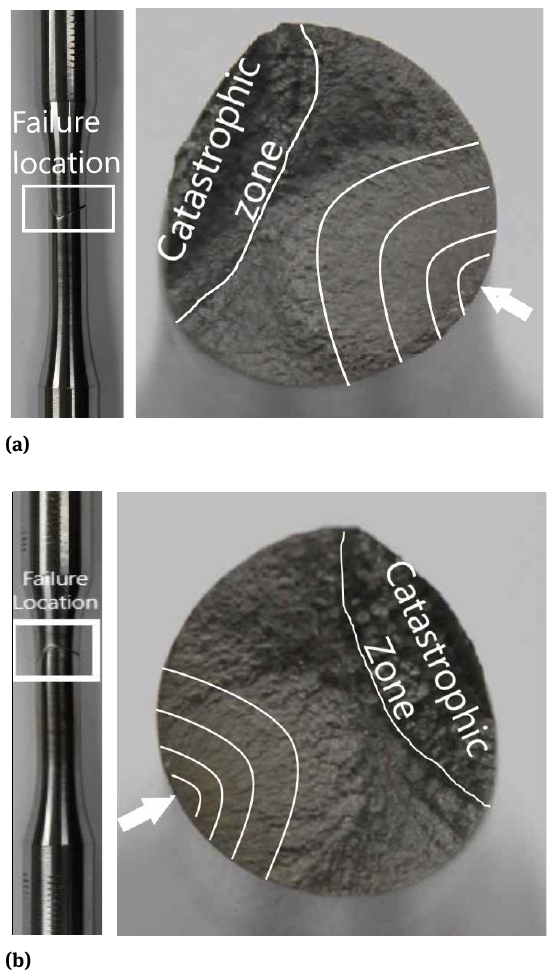
Figure 5: Macro-images of fractured fatigue specimens at: (a) 280 MPa, and (b) 300 MPa.